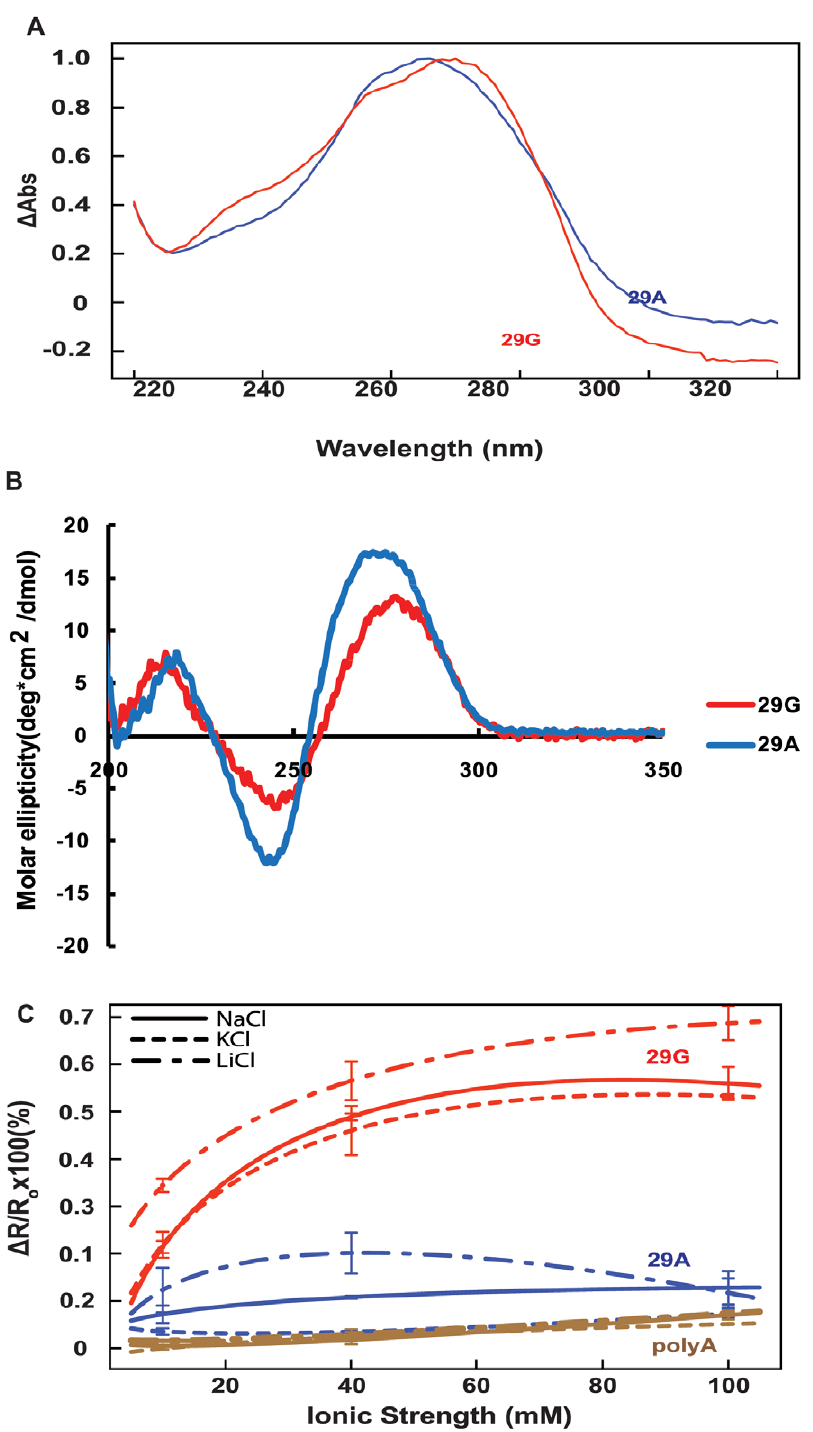
Figure 5. Salt Induced Folding of Single Strand Promoter Variant Oligos. ( A ) Normalized differential absorbance spectra of 29G (red) and 29A (blue). ( B ) CD spectra of 29G and 29A in presence of 40 mM NaCl. (C) Relative fluorescence ratio values in the presence of monovalent cations (Na + , K + , Li + ) for 29G (red) and 29A (blue). R = F em, 585/ F em, 518 calculated from emission spectra, l ex=475 nm. PolyA (brown) used as a non- structured control. indirectly through other interacting proteins is unclear. A recent transcription factor (ATF4) [21]. Differential distribution of such study has shown the ability of vimentin to regulate osteocalcin an interacting molecule(s) between NIH3T3 and MCF-7 cell lines transcription in immature osteoblasts through interaction with a may explain differences in P2 promoter activity between the two